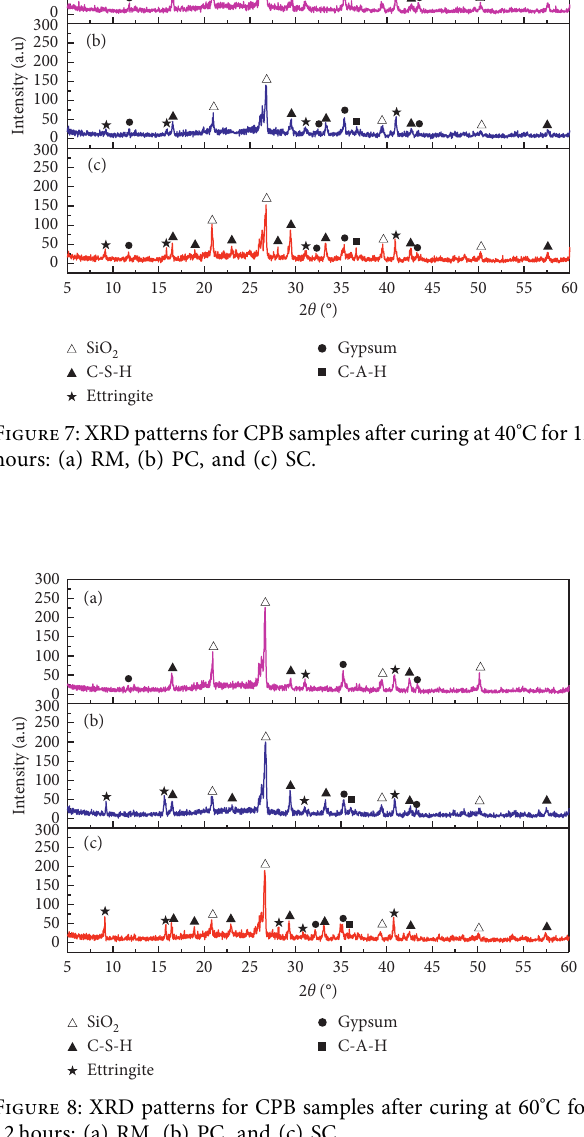
Figure 6: XRD patterns of CPB samples after curing at 20 ° C for 12 hours: (a) red mud (RM), (b) Portland cement (PC), and (c) slag cement (SC).